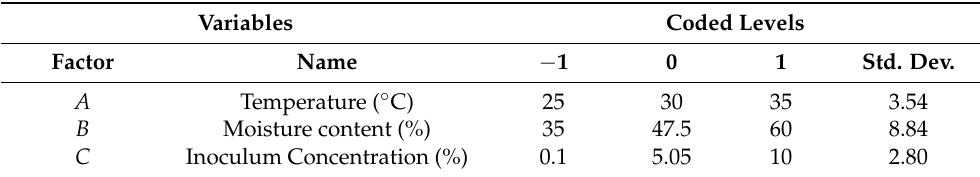
Table 3. Range, levels and code of independent variables chosen for the BBD of T. asperellum AU131. Variables Coded Levels Factor Name − 1 0 1 Std. Dev. A Temperature ( ◦ C) 25 30 35 3.54 B Moisture content (%) 35 47.5 60 8.84 C Incubation period (days) 14 21 28 4.95